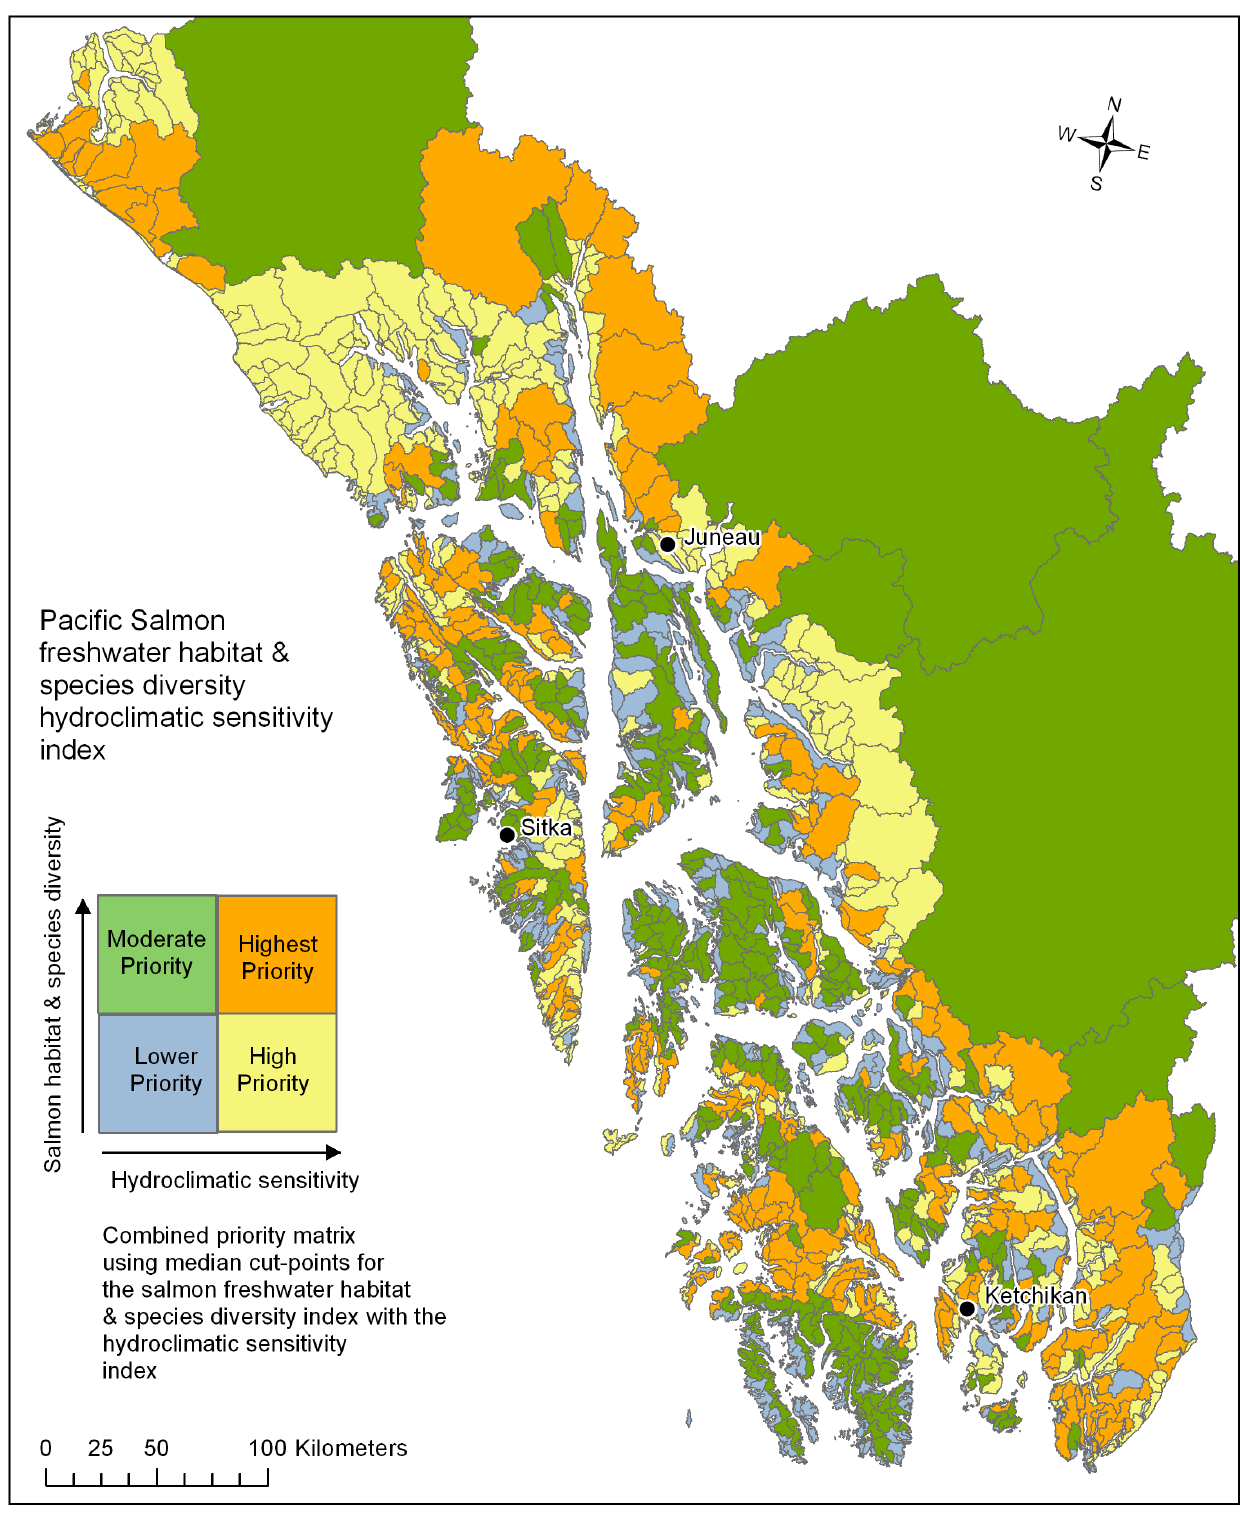
Figure 5. The watersheds of southeast, Alaska, USA (n=1784) showing the Pacific Salmon freshwater habitat and species diversity index combined with the hydroclimatic sensitivity index developed in this study.